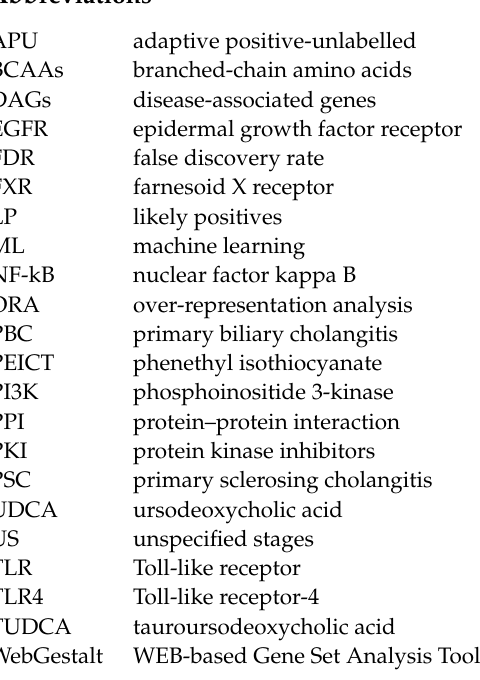
Table S2: Over-representation analysis (ORA) from Seed Genes results for drugs. Results are stratified by disease stages (Label column); Table S3: Over-representation analysis (ORA) from Likely Positives (LP) results for drugs. Results are stratified by disease stages (Label column); Table S4: Over-representation analysis (ORA) from Seed genes results for pathways. Results are stratified by disease stages (Label column); Table S5: Over-representation analysis (ORA) from Likely Positives (LP) results for pathways. Results are stratified by disease stages (Label column); Supplementary File S1: Detailed Methodology; Supplementary File S2: l-threonine Webgestalt re- sults; Supplementary File S3: l-serine Webgestalt results; Supplementary File S4: l-lysine Webgestalt results; Supplementary File S5: PA45261 Webgestalt results; Supplementary File S6: